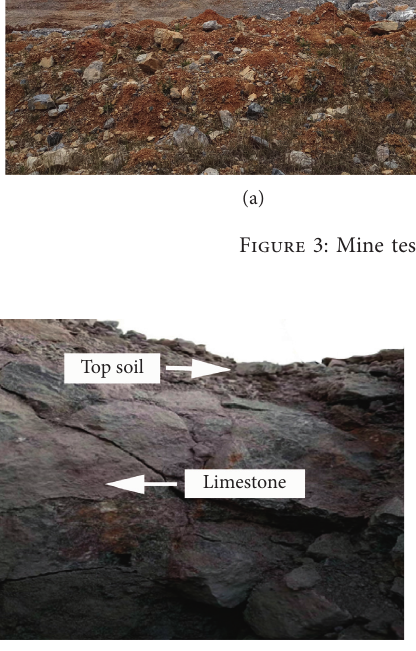
Figure 4: Photograph of the blast hole taken upward from the